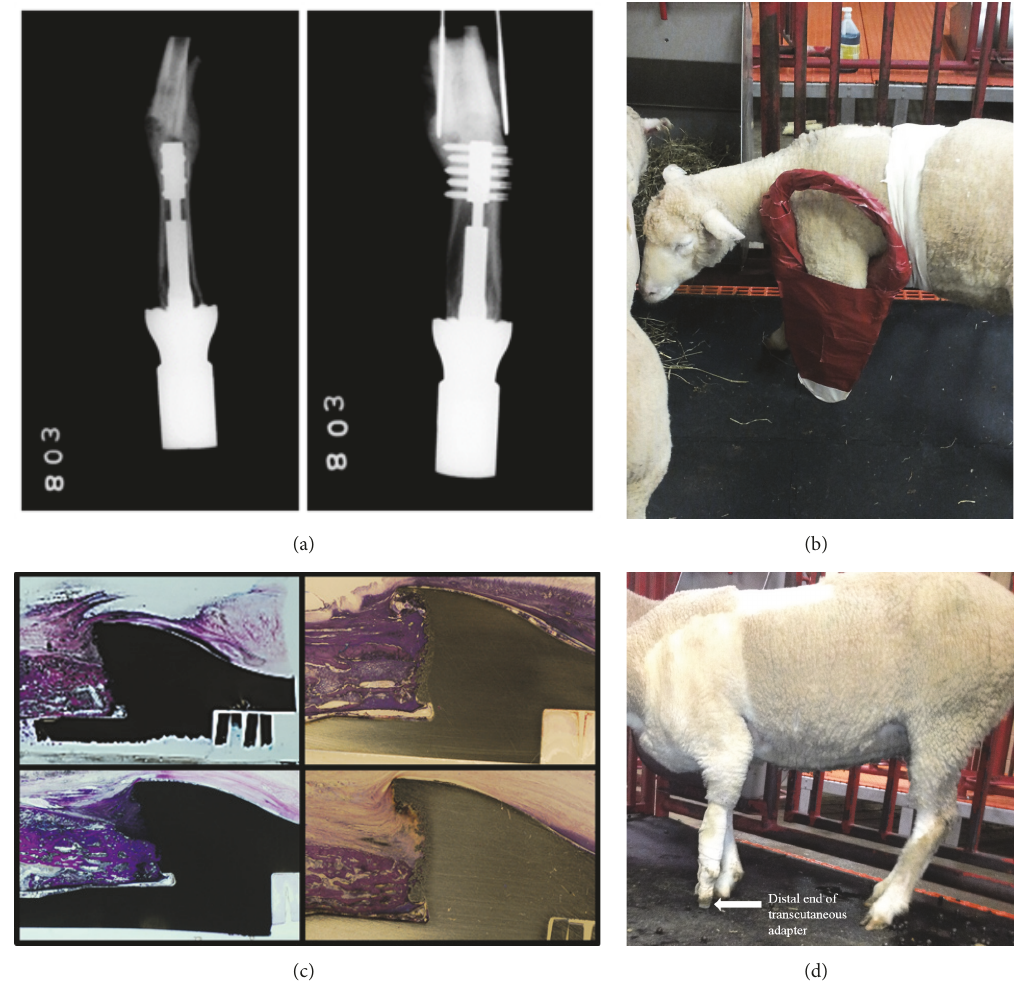
Figure 5: (a) This figure shows radiographs of the implant in Sheep 1B. (b) This figure displays the splinted extremity of the fractured animal, Sheep 1B. (c) This figure demonstrates histological analysis of the osseointegration at all four quadrants in Sheep 1B. (d) This photograph taken after the second surgery demonstrates the animal weight bearing without restriction on the transcutaneous